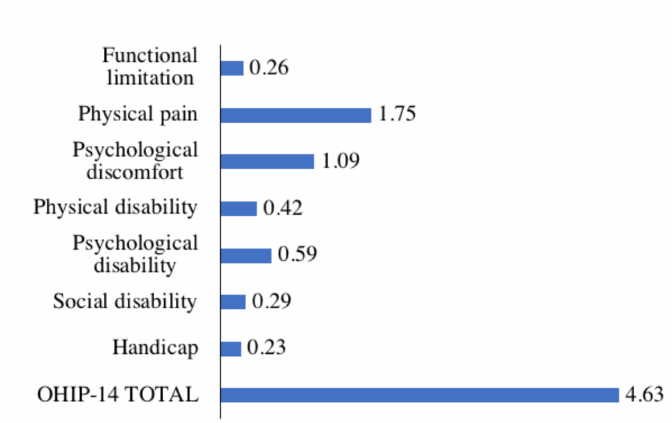
Figure 2. Mean Oral Health Impact Profile 14 (OHIP-14) score (by dimensions and total) in the study sample ( n = 666). Table 1. Frequency of responses to items in the Oral Health Impact Profile 14 (OHIP-14) in the study sample.